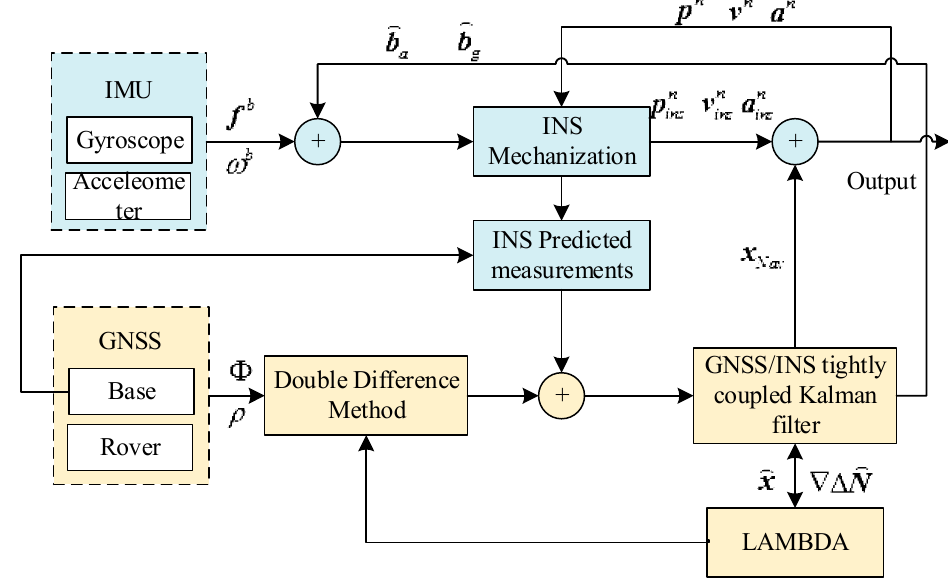
Figure 1. The principle of global navigation satellite system / inertial navigation system (GNSS / INS) tightly coupled ambiguity